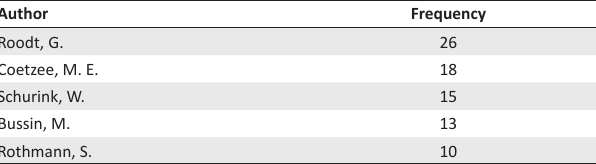
TABLE 3: Top five author statistics: South African Journal of Human Resource Management , 2003–2015.